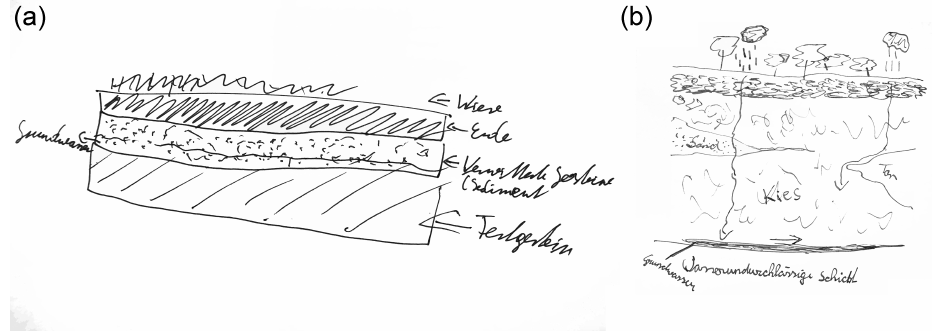
Figure 2. Examples for the categories of analysis. Geologically correct drawings ( b student; a pupil). Wiese (grasland), Erde (soil), Fest- gestein (hard rocks), Grundwasser (groundwater), wasserundurchlässige Schicht (unpermeable layer), Kies (gravel) Ton (clay).